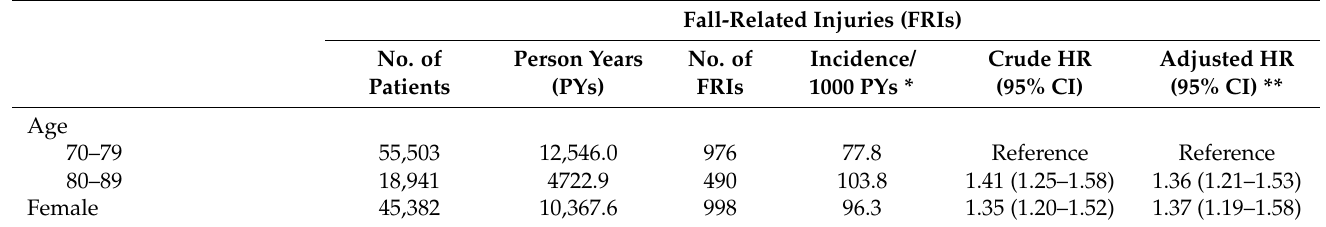
Table 3. The incidence rates and risks of fall-related injuries according to